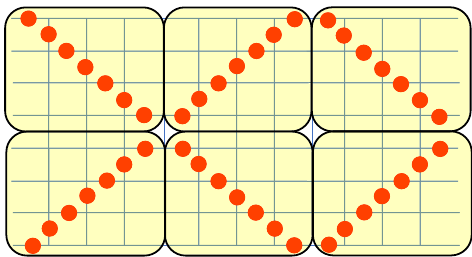
FIG. 9. Partition of the 8 × 12 surface code into 4 × 4 tiles. Solid red circles: The extended diagonal Δ 1 alternating between δ 1 and δ 5 ; see Fig. 6.